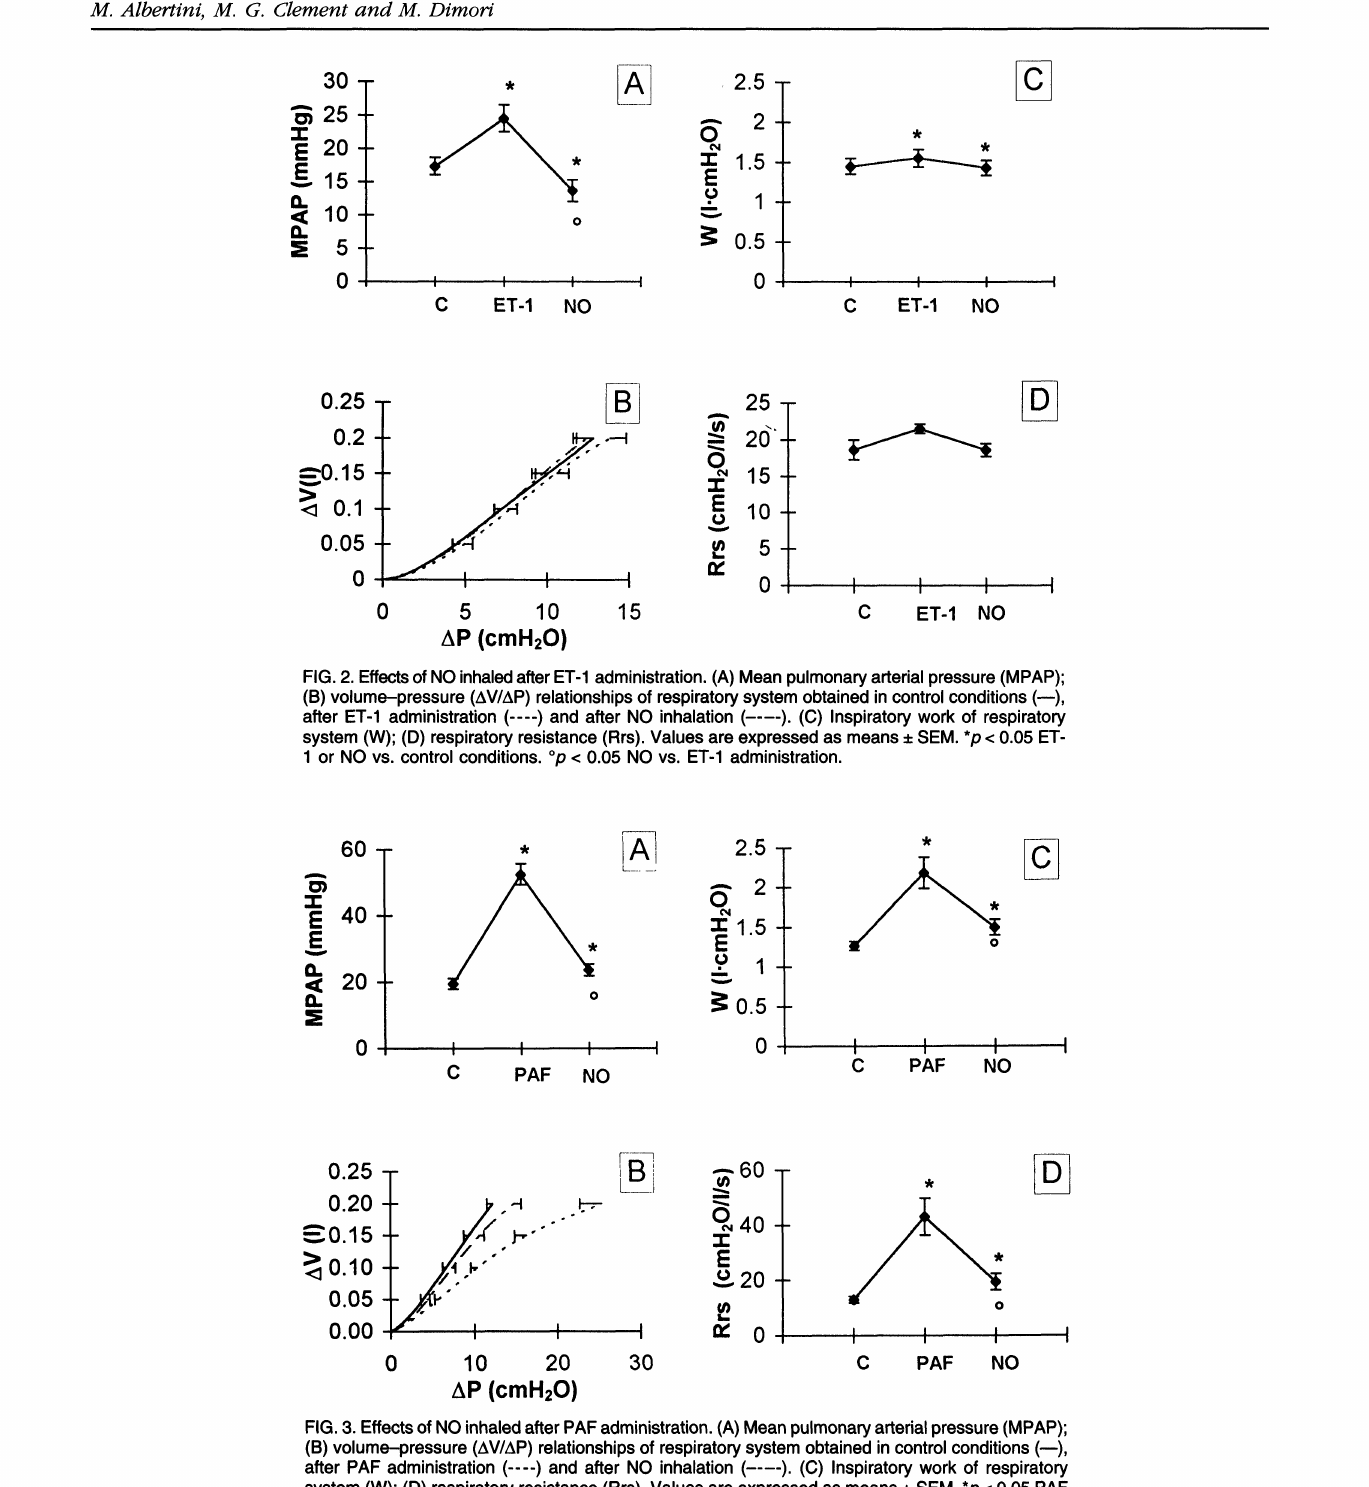
FIG. 3. Effects of NO inhaled after PAF administration. (A) Mean pulmonary arterial pressure (MPAP); (B) volume-pressure (zV/zP) relationships of respiratory system obtained in control conditions (--), after PAF administration and after NO inhalation ). (C) Inspiratory work of respiratory system (W); (D) respiratory resistance (Rrs). Values are expressed as means +/- SEM. *p < 0.05 PAF or NO vs. control conditions. Op < 0.05 NO vs. PAF